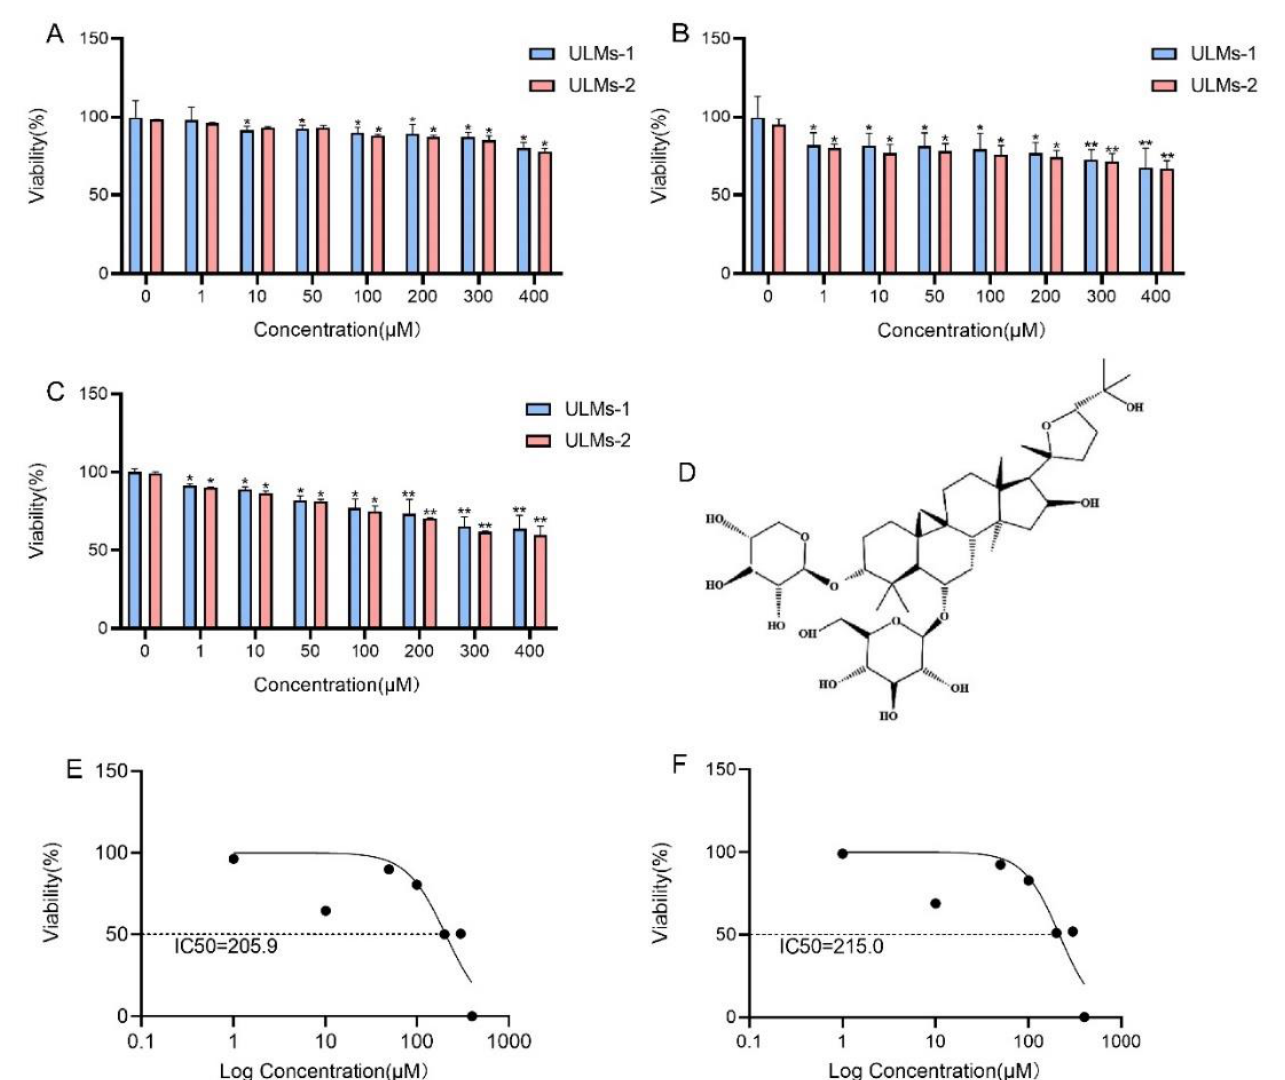
Figure 1. Effect of AS-IV on the proliferation of ULM cells. ULM-1 cells and ULM-2 cells were treated in various concentrations of AS-IV (0, 1, 10, 50, 100, 200, 300, and 400 μM), and changes in cell viability were observed at ( A ) 24 h, ( B ) 48 h, and ( C ) 72 h. ( D ) Chemical structure of AS-IV. IC50 values of ULM-1 ( E ) and ULM-2 cells ( F ) were calculated using GraphPad prism8 and non-linear regression. The data are expressed as the mean ± SD. (* p < 0.05, ** p < 0.01 compared with the control group).